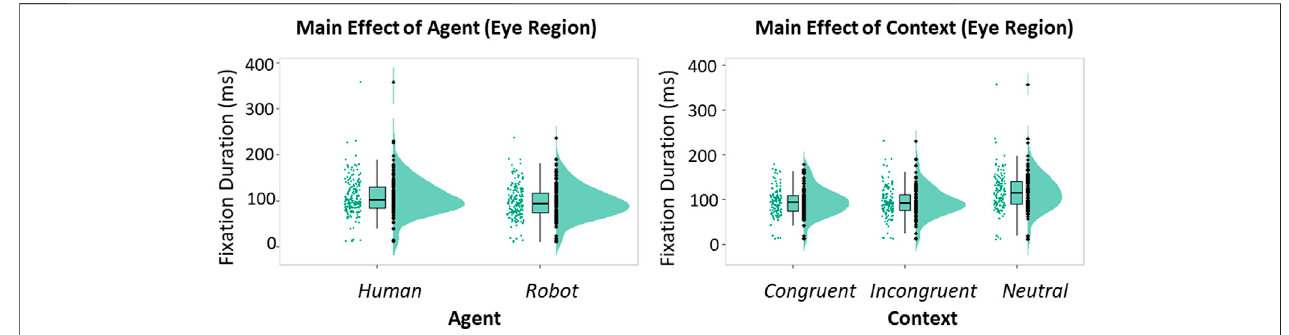
FIGURE2| Raincloudplotsshowingthe fi xedeffectonFixationDurationduetothemaineffectsofAgent (A) ,andContext (B) (GLM).Boxplotsassociatedwiththe raincloud plots depict median values (black horizontal lines), interquartile ranges (black boxes), and upper-lower quartile intervals (black whiskers).